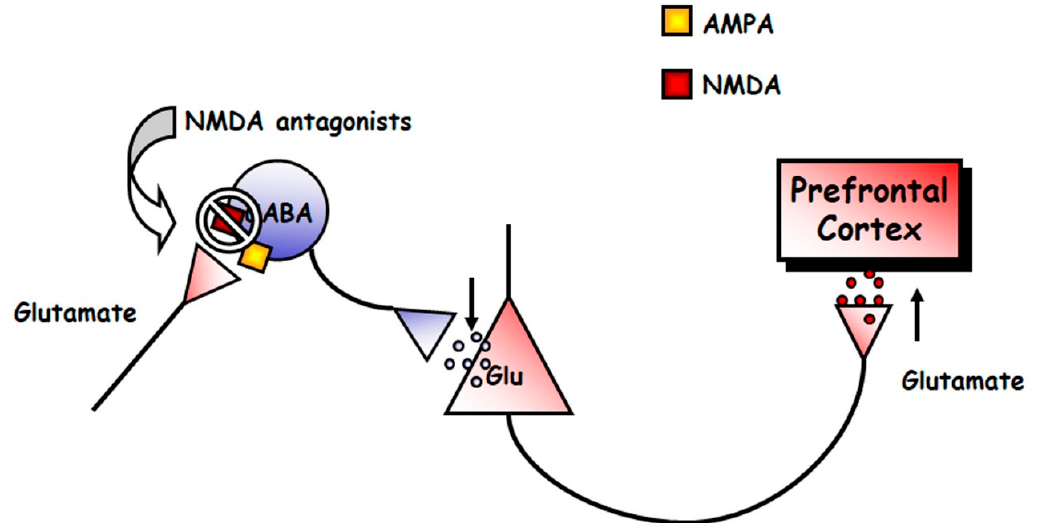
Figure 3. Scheme of the mechanism of action of NMDAR antagonists. These drugs would block NMDAR in a population of tonically active γ -aminobutyric acid (GABA)ergic neurons. This would decrease the activity of these neurons, and the consequent decrease in GABA release would cause the disinhibition of glutamatergic neurotransmission. The glutamate released would lead to the stimulation of α -amino-3-hydroxy-5-methyl-4-isoxazolepropionic acid (AMPA) receptors in pyramidal cells, which would result in the described state of